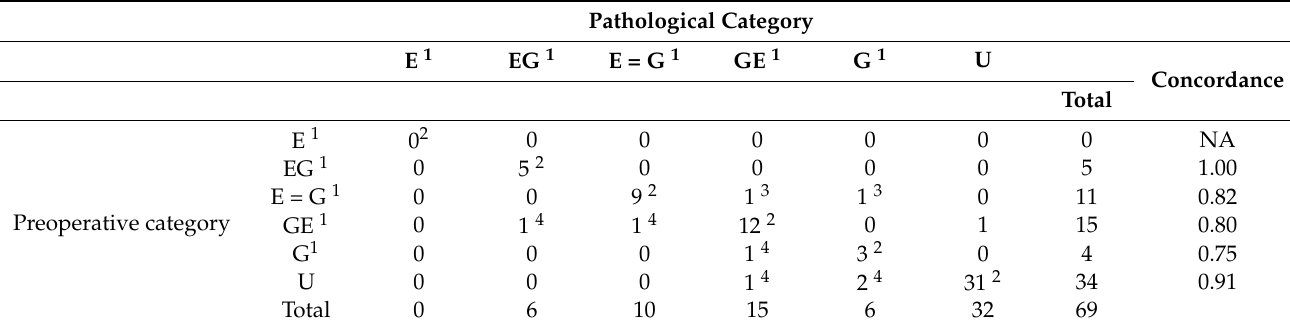
Table 1. Collation of the preoperatively estimated and pathologically confirmed tumor categories for 69 eligible patients with a tumor epicenter located between the abdominal esophagus and the upper gastric fundus.